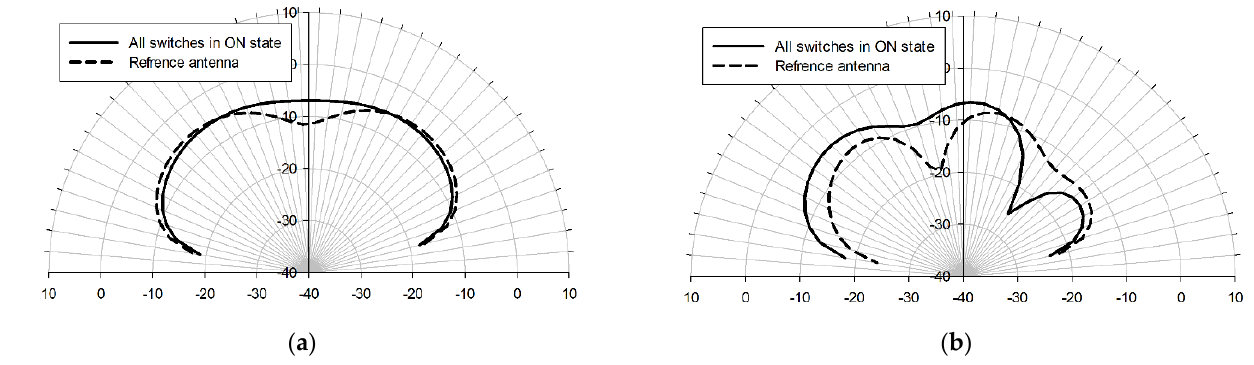
Figure 5. E-plane (xz-plane) ( a ) and H-plane (yz-plane) ( b ) radiation patterns (realized gain) of the reference and pixel antennas operating at 50 THz. The simulations were done with the Sonnet Pro- fessional software.